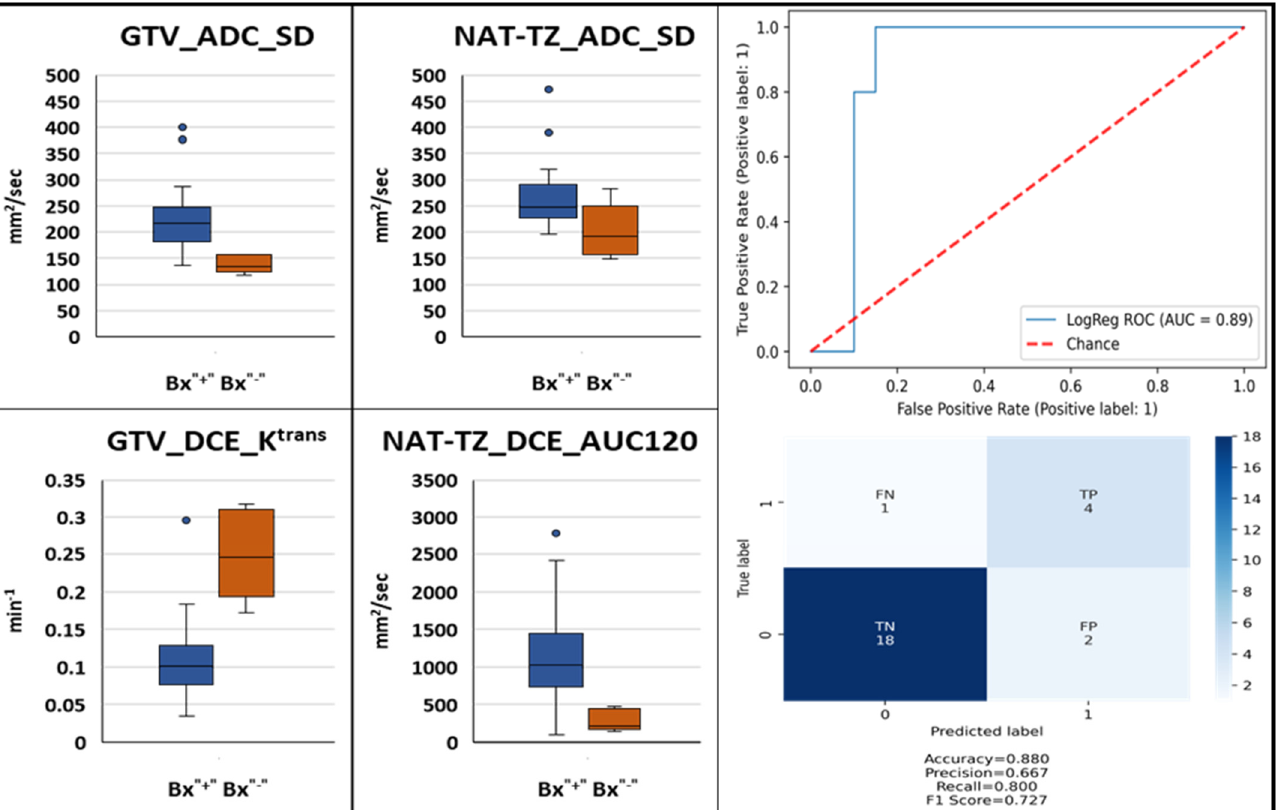
Figure A1. Three-months post-RT mpMRI-based model for the prediction of second year post-RT biopsy positivity. Box and whisker plots of identified significantly different ( p -value < 0.05) quantitative ADC and DCE imaging features between patients with negative and positive second year biopsy ( left ). Receiver operating characteristic curve of a logistic regression model built using these baseline features and confusion matrix ( right ). Table A1. MRI acquisition parameters for mpMRI sequences.